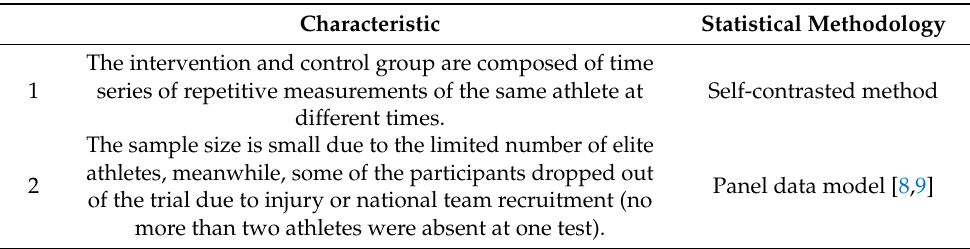
Table 1. Two main characteristics of the observed